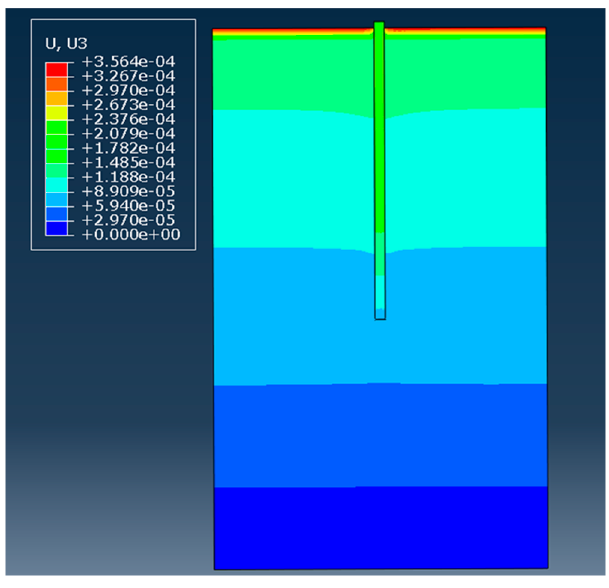
Figure 12. Vertical displacement nephogram of soil after stress equilibrium.